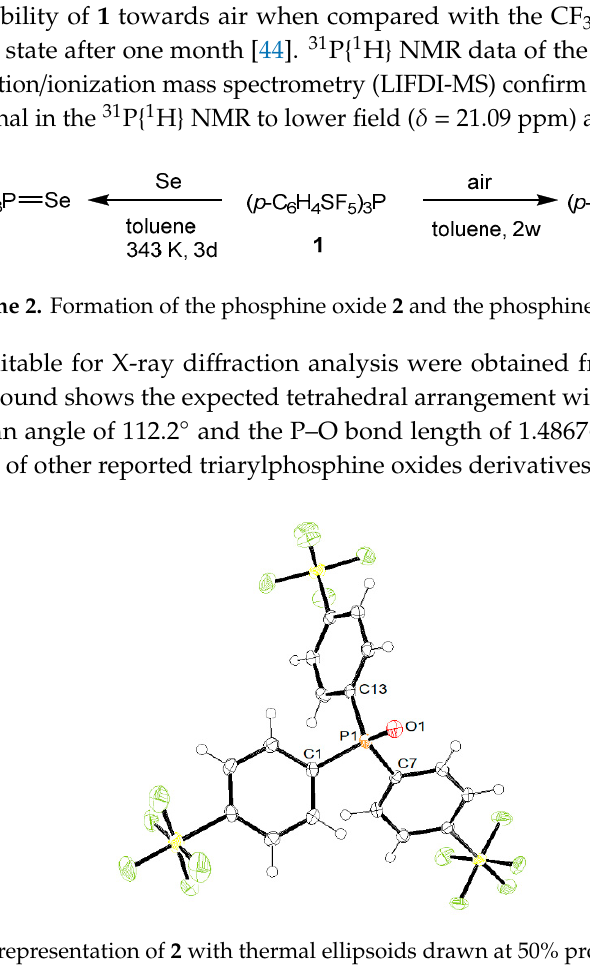
Table 1. DFT calculated SOMO energies (eV) of triarylphosphines radical cations [PAr 3 ] •+ (CAM- B3LYP/6-311G(d,p)).